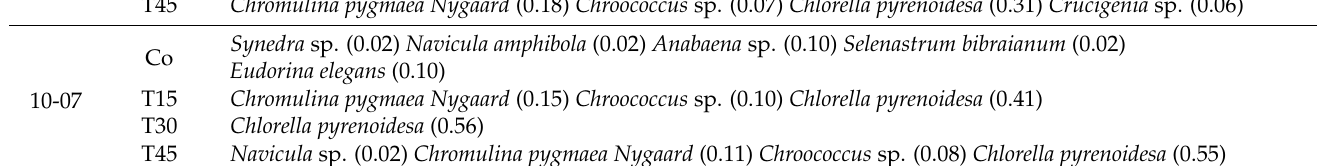
Table A6. Biomass and species of zooplankton in the enclosures of each treatment group ( n = 3).